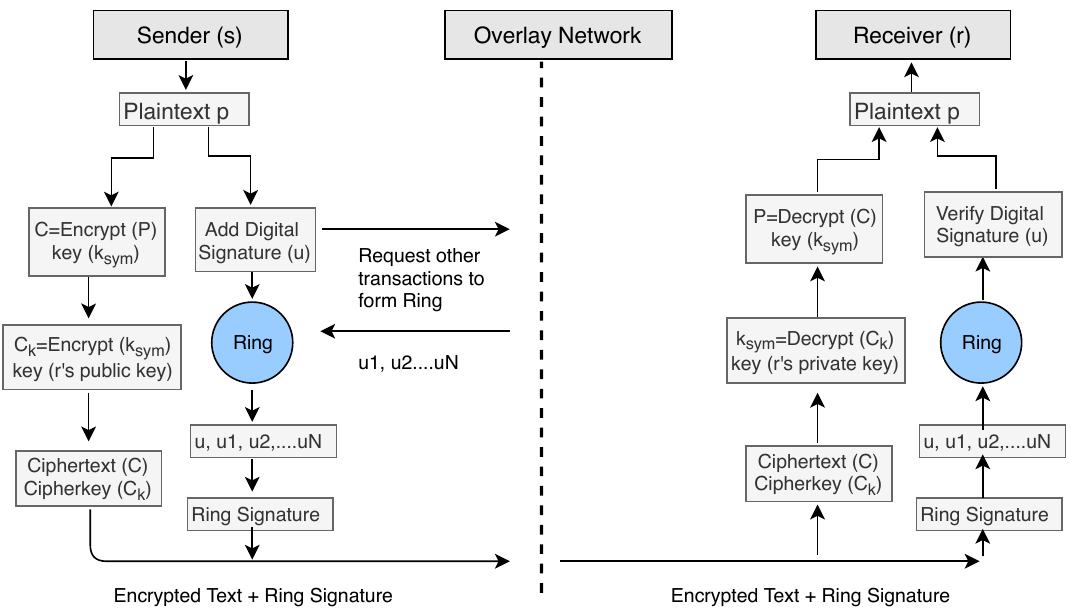
Figure 11. Block Diagram of